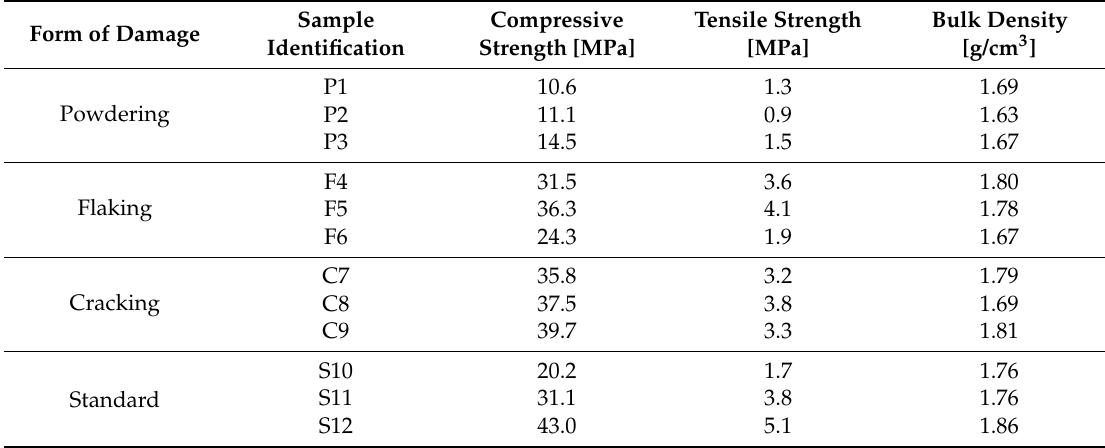
Table 2. Results of compressive strength, tensile strength and bulk density